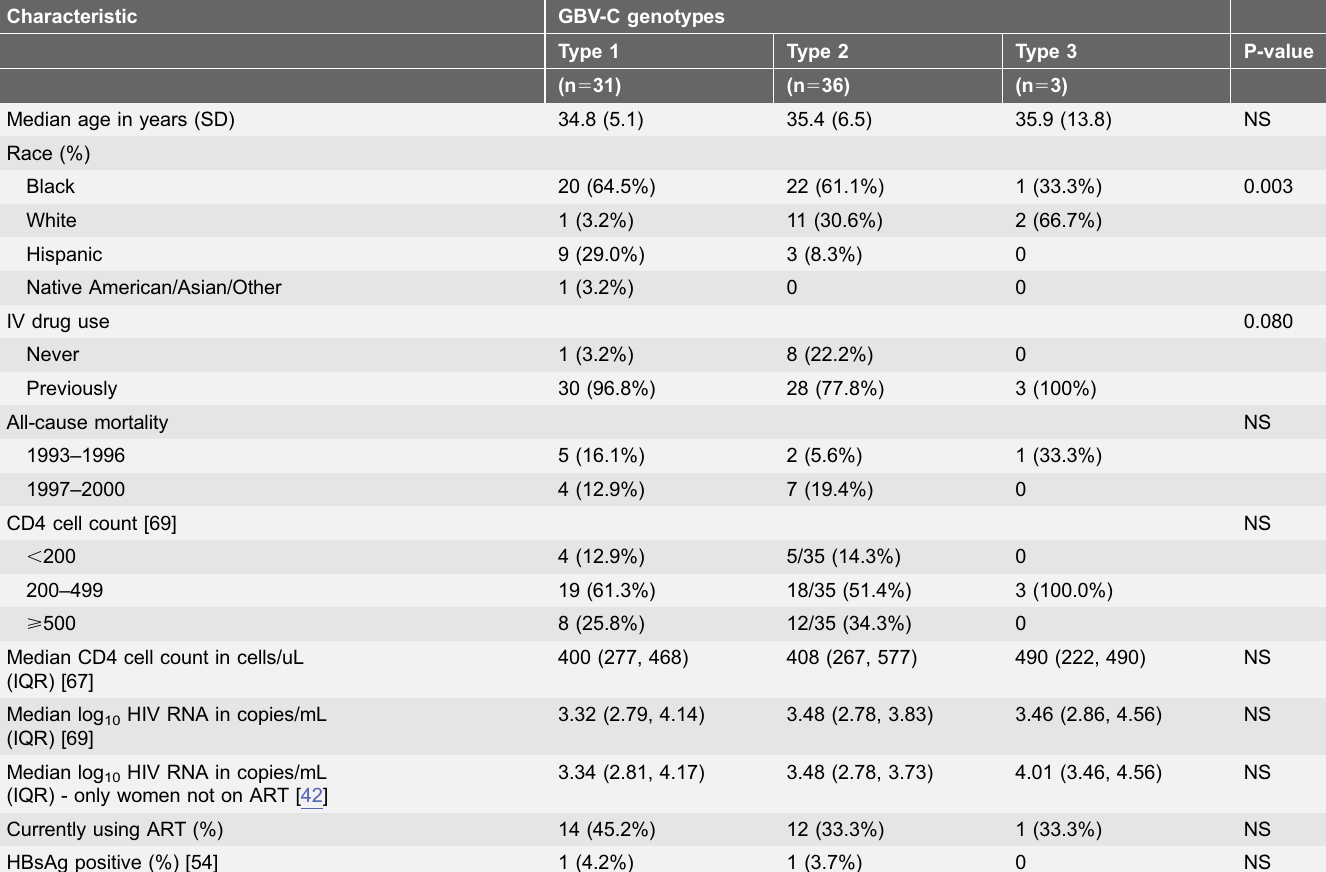
Table 3. Demographic and clinical data 70 HIV/GBV-C co-infected women from the HERS cohort included in the current